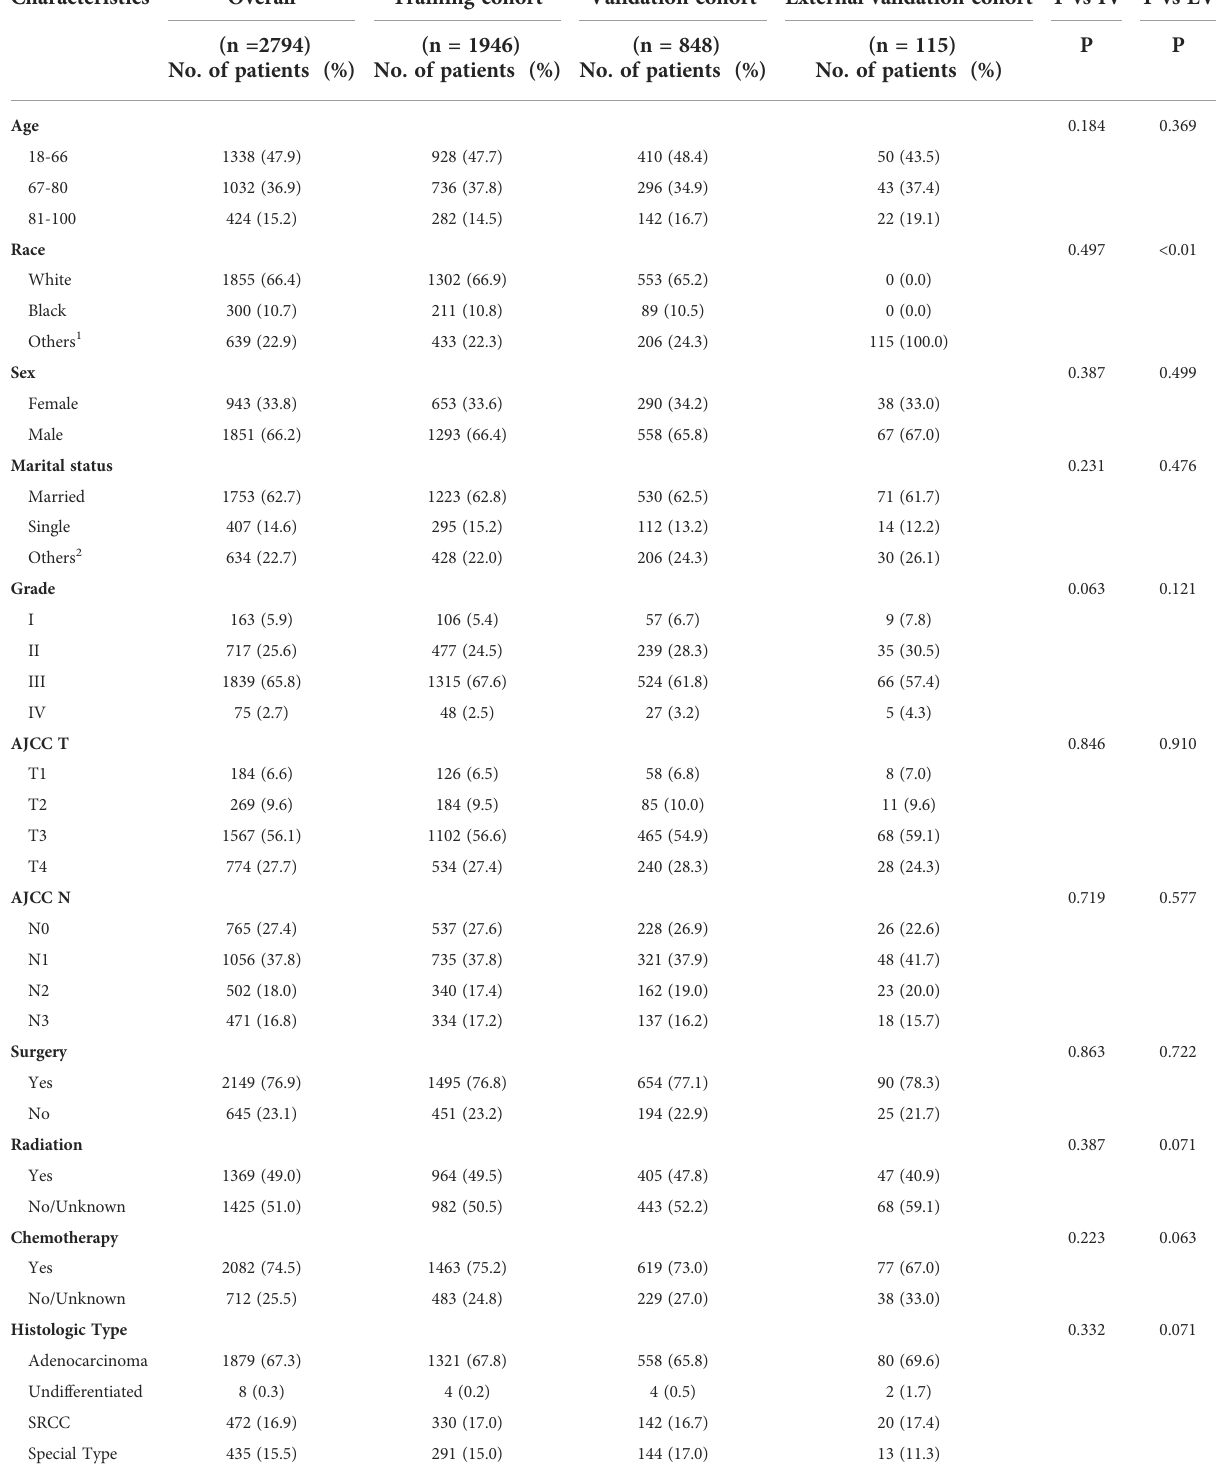
TABLE 1 Characteristics of patients with LAGC in the training and validation cohort.